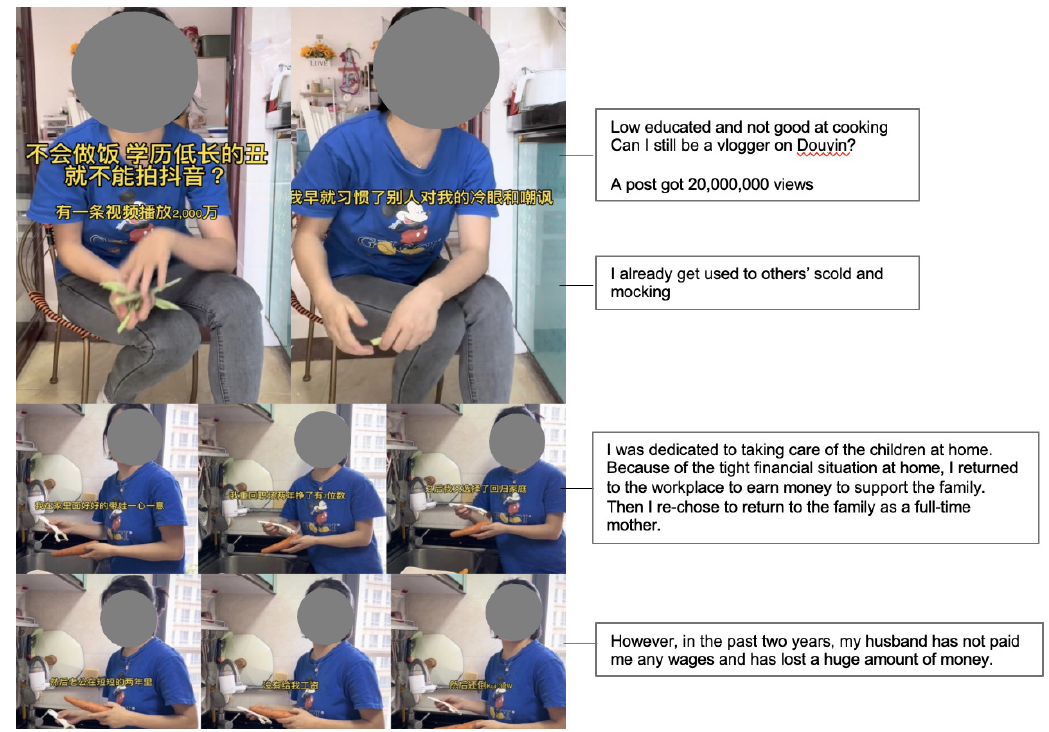
Figure 7. Screenshots of Yu’s post. similar to other female bodies that chose to pursue other trajectories (Oh,